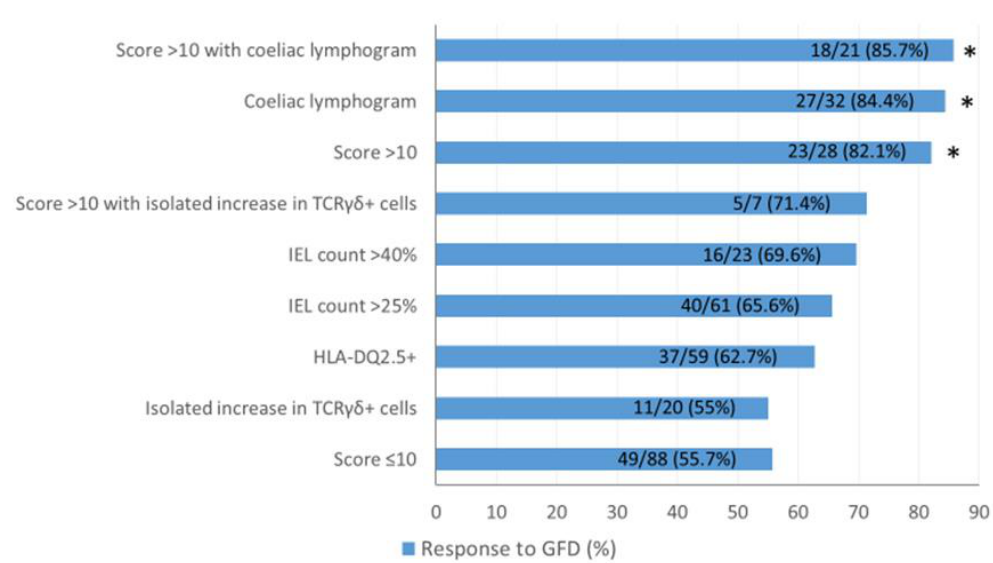
Figure 1. Response rate to a GFD in function of the presence of the different coeliac parameters and the low-grade coeliac score (* p < 0.012 vs. score ≤ 10). The different parameters are interrelated, the score integrates individual parameters, and it is not possible to separate the scoring system from the coeliac lymphogram: most patients with a positive score (>10) had a coeliac lymphogram and vice versa.